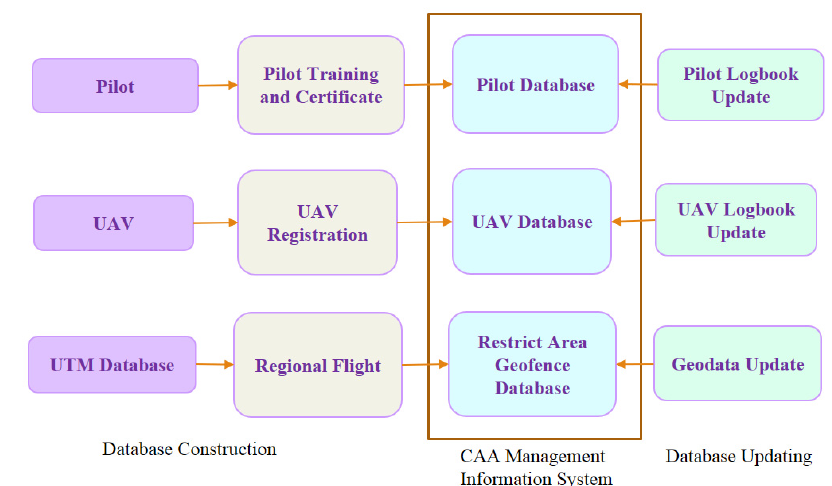
Figure 6. The proposed UTM system structure for tests.